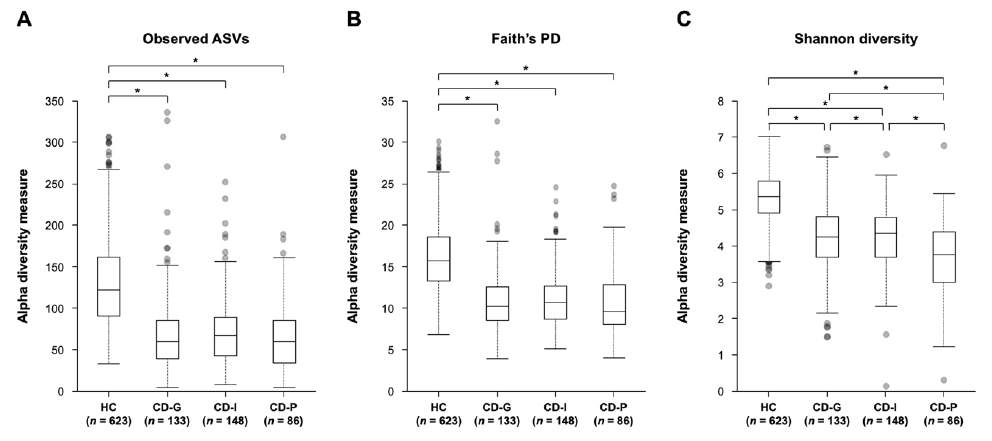
Figure 2. Alpha diversity comparisons of gut microbial communities among groups, according to the Crohn’s disease prognosis. ( A ) Observed ASVs, ( B ) Faith’s phylogenetic diversity, ( C ) Shannon index. * q < 0.05 (pairwise Kruskal–Wallis test, Benjamini–Hochberg correction). CD-G = good prognosis group; CD-I = intermediate prognosis group, CD-P = poor prognosis group; HC = health control.